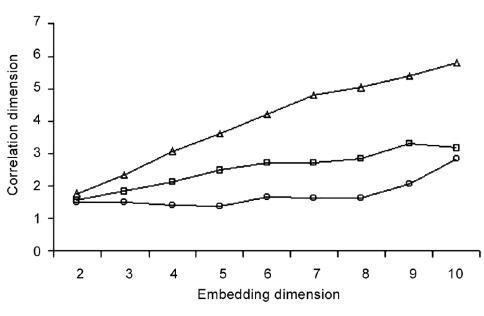
Fig. 13. Correlation dimension versus embedding dimension of 1000 data waiting times sequences of the whole catalogue after largest events: circles – time period before beginning of experiments (1975- 1983); squares – time period during experiments (1983-1988); triangles – time period after accom- plishing of experiments